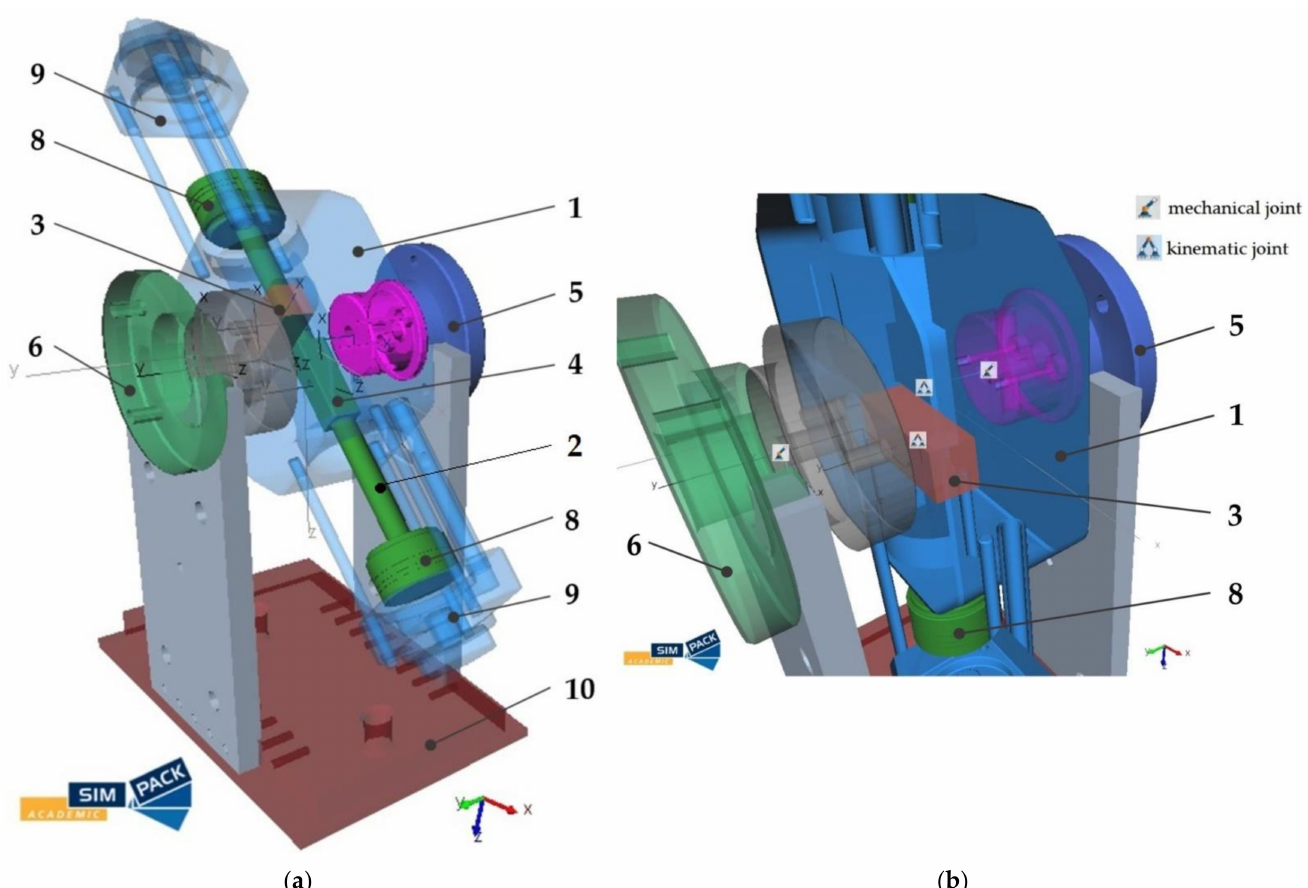
Figure 8. A multibody model of the engine in the Simpack software package ( a ), the detail of joints (mechanical and kinematic joints) ( b ): 1—a plate, 2—a connecting rod, 3—an auxiliary stone, 4—a stone, 5—a first output, 6—a second output, 8—pistons, 9—heads of cylinders, 10—a